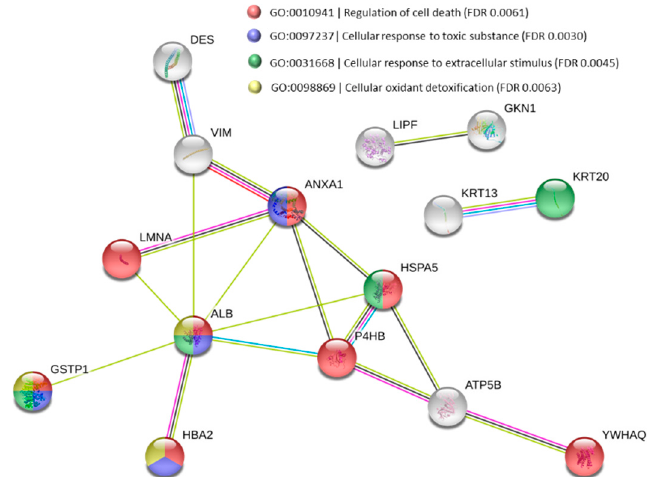
Figure 4. Protein–protein interaction map of 15 differential proteins between test groups. Three biological processes were characteristic of disease progression. Nodes are representative of protein species and lines represent protein–protein association. Nodes of the same color and/or joined by lines represents to a shared function. The STRING tool (http://www.string-db.org) was used to construct the interaction networks. Desmin (DES); vimentin (VIM); annexin A1 (ANXA1); prelamin-A/C (LMNA); serum albumin (ALB); glutathione S-transferase p (GSTP1); hemoglobin subunit beta (HBA2); Endoplasmic reticulum chaperone BiP (HSPA5); protein disulfide-isomerase (P4HB); ATP synthase subunit beta (ATP5B); 14-3-3 protein theta (YWHAQ); gastric triacylglycerol lipase (LIPF);